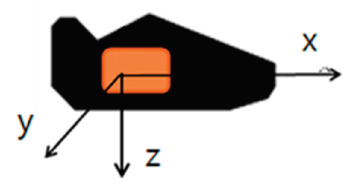
Figure 6. Frame of the sensor attached at the right foot.